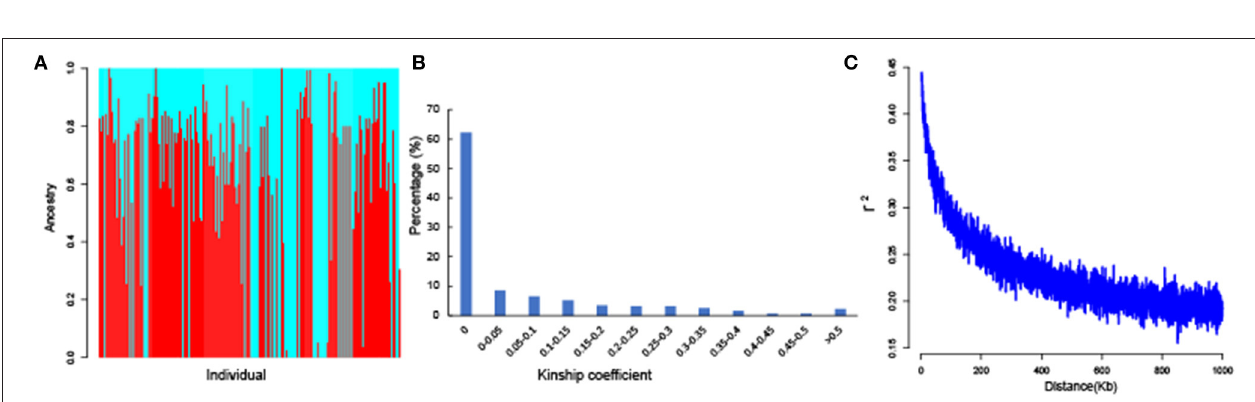
FIGURE 2 | Single-nucleotide polymorphism (SNP) distributions on the 26 chromosomes of G. hirsutum races. A1–A13 and D1–D13 on the vertical axis represent the serial numbers of the 26 chromosomes; the horizontal axis shows chromosome length; the window size is 1Mb.